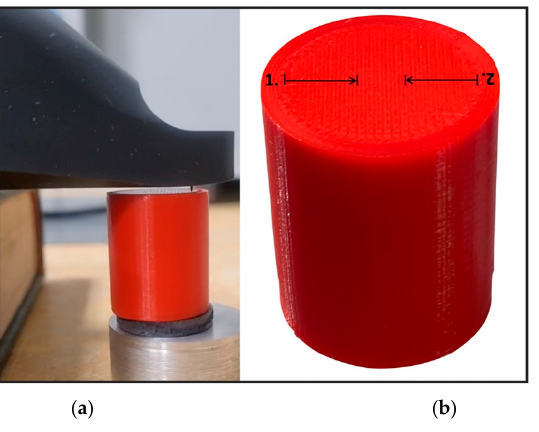
Figure 6. ( a ) The setup for the roughness test; ( b ) mapping distance during the roughness measure- ment. Surface roughness parameters (Sa and Sq) were measured by a 3D optical profilometr (Leica Microsystems DCM8). Images were taken over a 2 × 1.8 mm area of the side